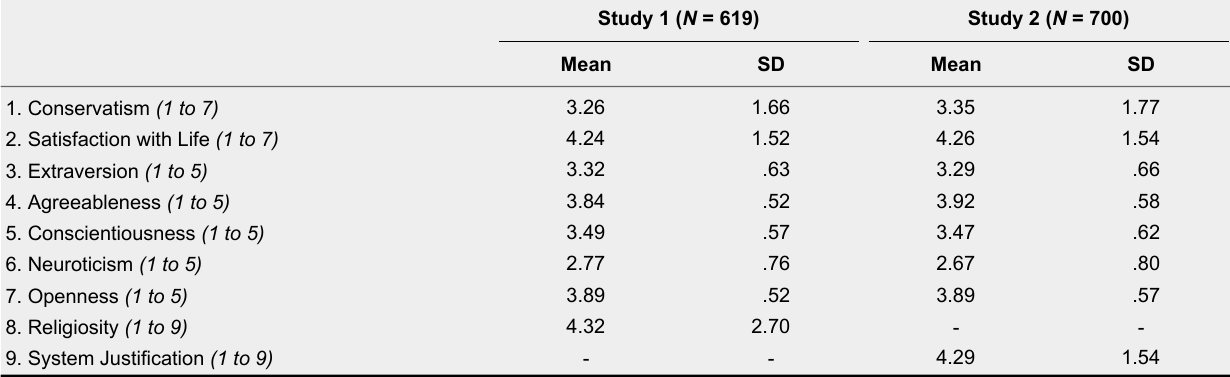
Descriptive Statistics for Variables in Studies 1 and